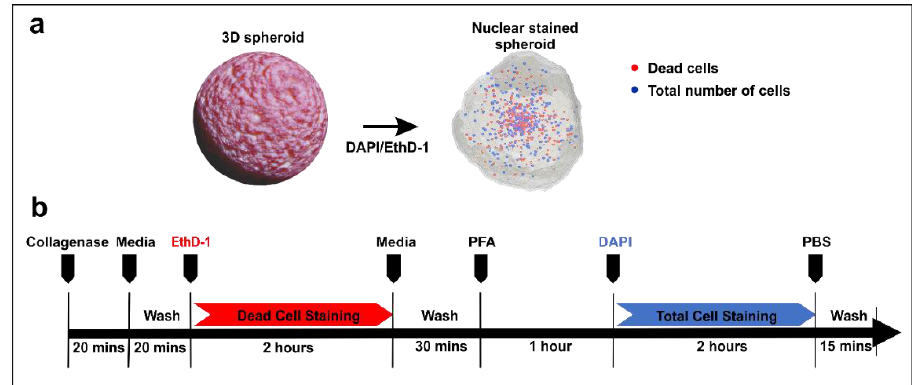
Figure 1. Working principle and procedures in the quantitative image-based cell viability (QuantICV) assay. ( a ) A pair of cell-impermeant nucleic acid dyes (EthD-1/DAPI) was used to selectively label the nuclei of necrotic and total cell population. ( b ) Cell labeling procedure. The cells were first stained with EthD-1 to mark the existing dead cell population followed by sample fixation and staining with DAPI to label the entire cell population.